Question: In a single sentence, describe what this figure presents.
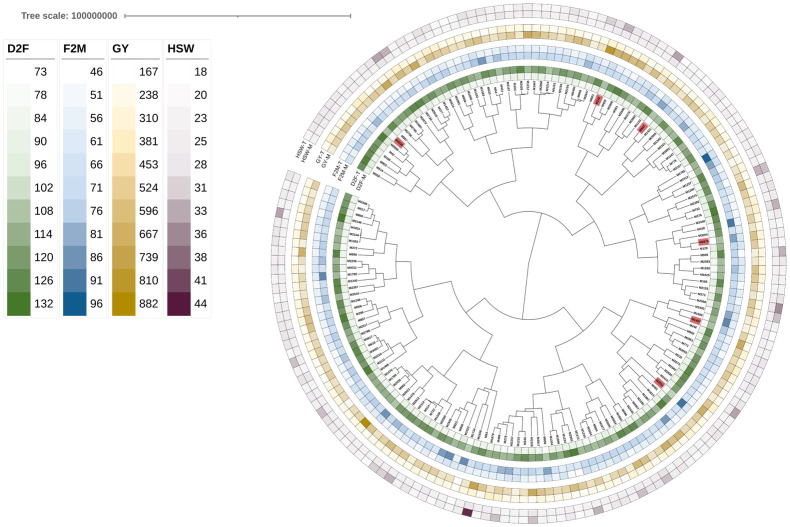
Answer: Dendogram showing the agronomic performances of the genotypes of this population at Marchouch (M) and Terbol (T). Genotypes highlighted in red: Genotypes with good agronomic performance in both environments.